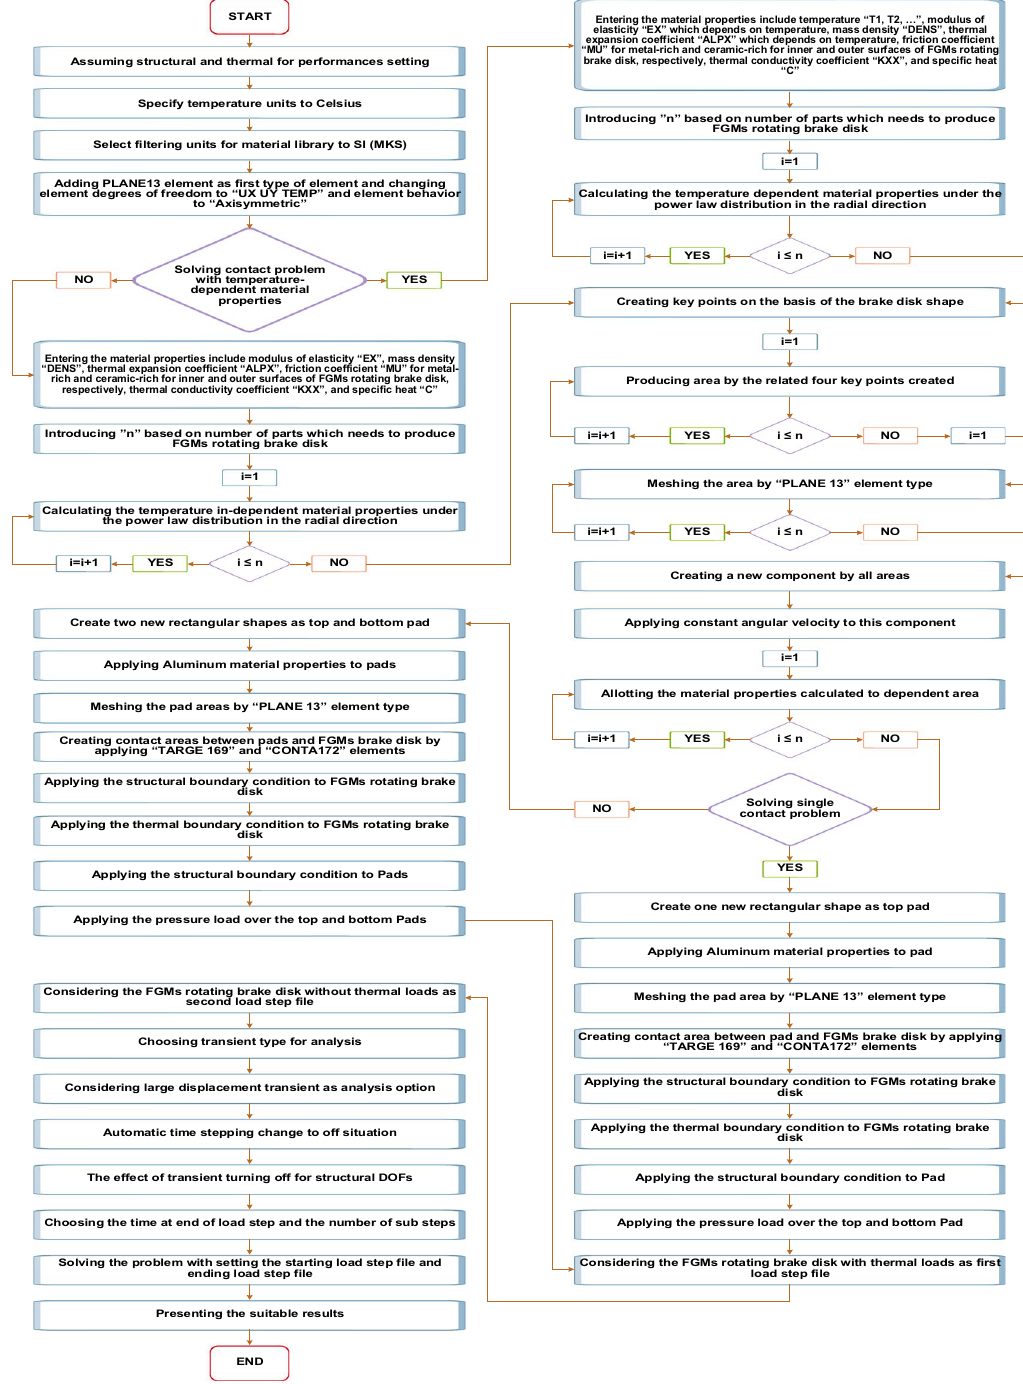
Figure 3. Flow chart of FEM scheme for temperature-dependent and temperature-independent FGMs brake